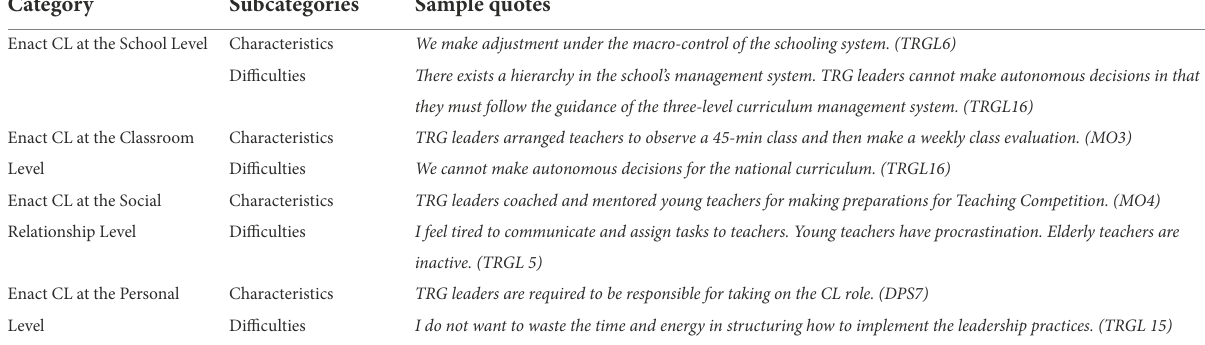
TABLE 3 Sample of data coding